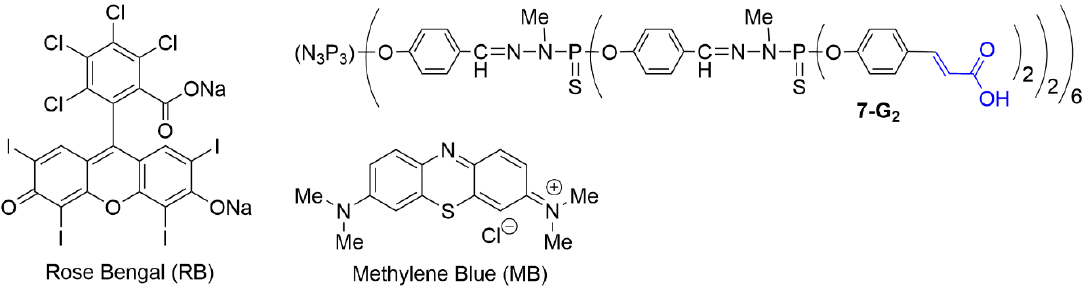
Figure 11. Chemical structure of the photosensitizers Rose Bengal and Methylene Blue, and of dendrimer 7-G 2 . dendrimer 7-G 2